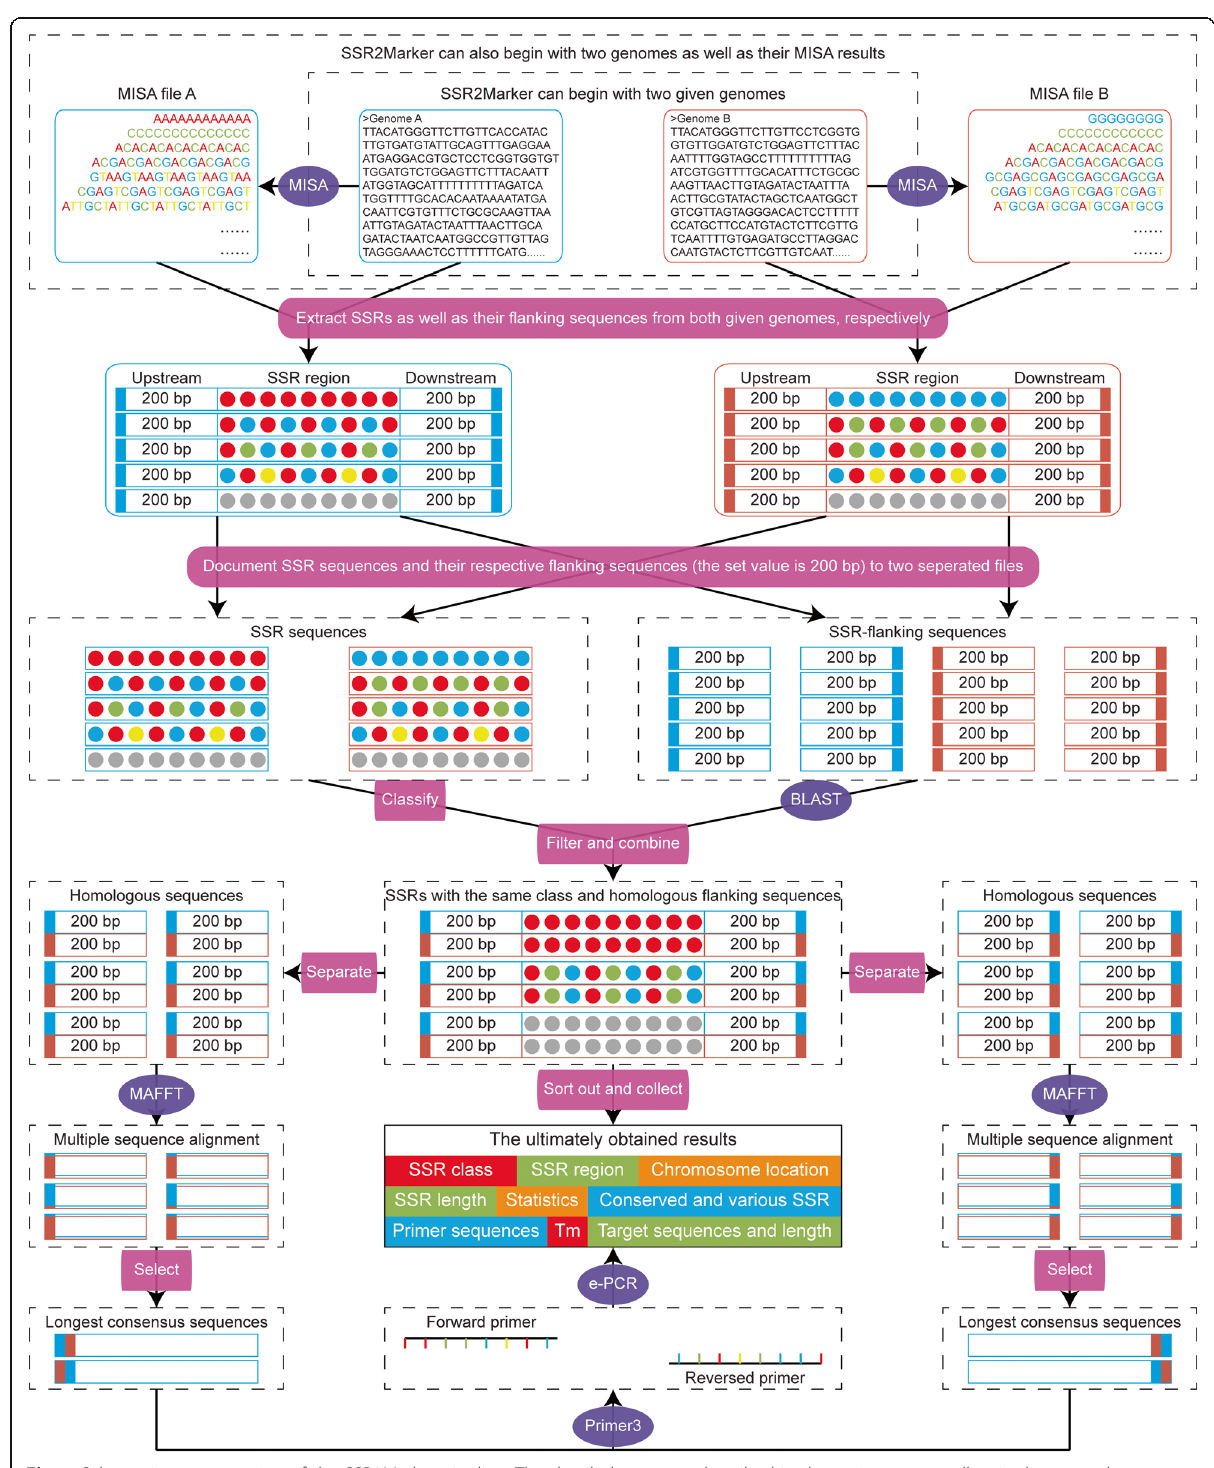
Fig. 1 Schematic representation of the SSR2Marker pipeline. The detailed steps are described in the main text as well as in the manual released